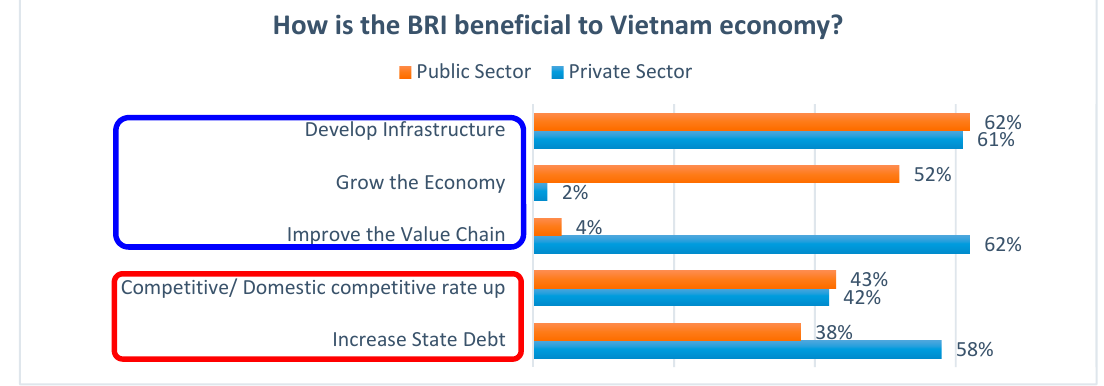
Figure 4. Perceived macro-level benefits and key concerns to the economy (Source: Authors’ analysis).